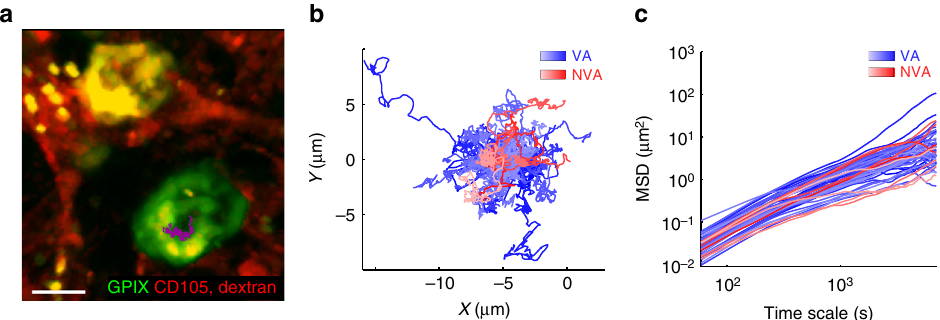
Fig. 1 MK tracking reveals low motility of MKs in vivo. a A representative centroid track ( magenta ) from a MK ( green , scale bar 15 µ m) monitored for over 3 h. Frame rate: 1 f/min b Trajectories of individual MKs ( n = 54 from six different mice) over a time period of 3 h; individual trajectories of MKs are represented by different blue (vessel-associated, n = 46) and red (non-vessel associated, n = 8) shadings. Frame rate: 1 f/min c MSD analysis of individual MKs ( n = 54) for different time scales. Corresponding α coef fi cients can be derived from slopes in the log-log-plot; MSD curves of individual MKs are represented by different blue (vessel-associated, n = 46) and red (non-vessel associated, n = 8)